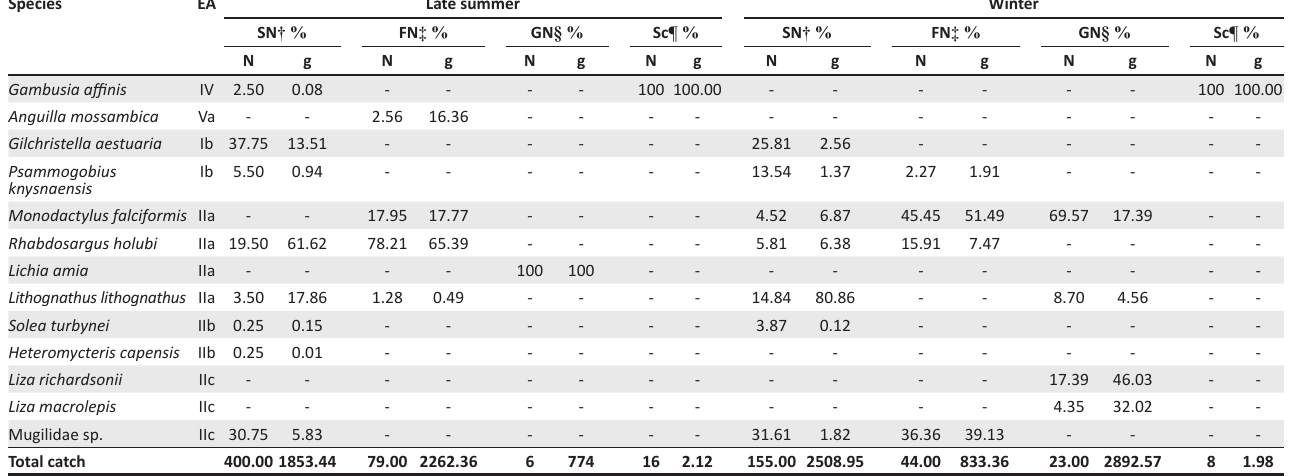
TABLE 2: Relative abundance and biomass of fishes captured during surveys conducted in the Noetsie Estuary between late summer and winter 2015. Species